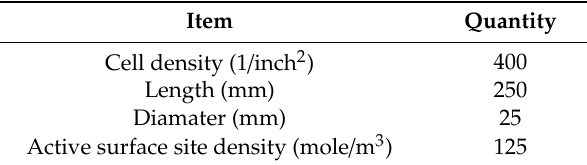
Table 2. Configuration parameters of SCR in GT power.